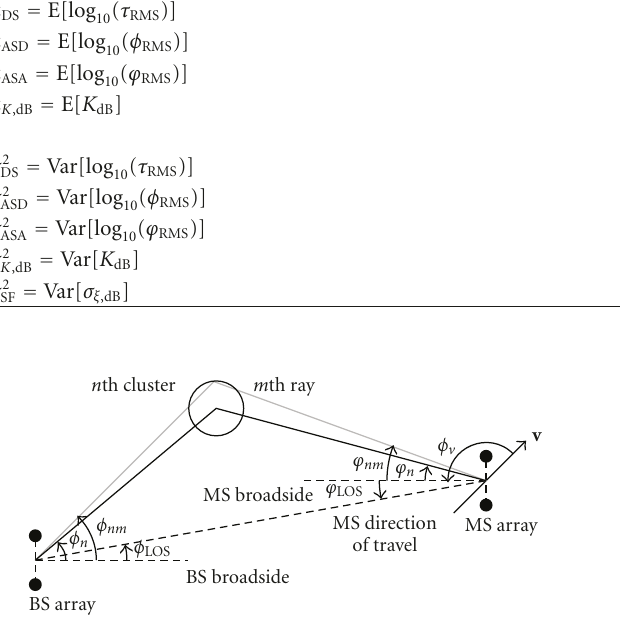
Figure 1: Definition of angles in WINNER channel